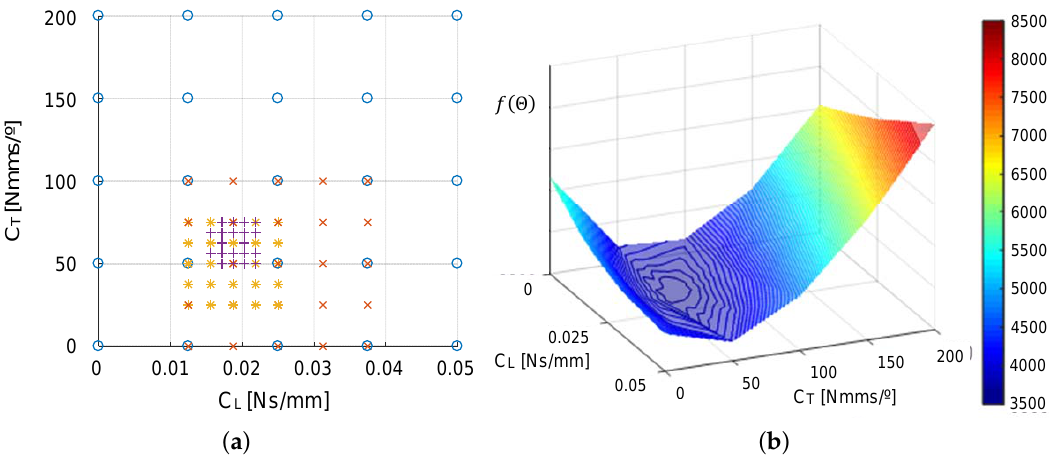
Figure 7. Grid optimization method: ( a ) grid of discrete points on Ω ; ( b ) surface plot of function f ( Θ ) .